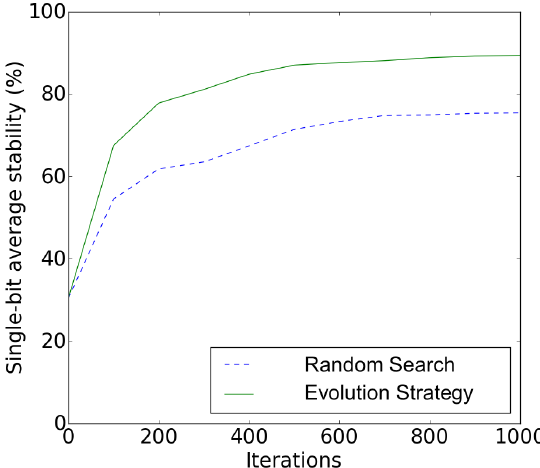
Figure 6. Stability of 1000 test conducted on the test IPN instances. Environmental variance: 0.8 V ∼ 1.0 V, 0 ∼